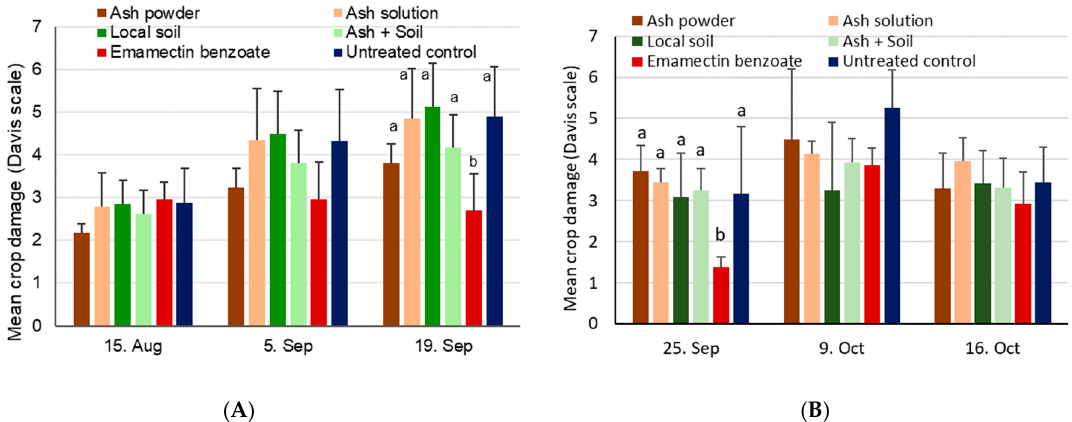
Figure 8. Mean crop damage induced by FAW + SD after application of ash- or soil-based treatments during vegetative growing stages conducted in the 2018 season. Within a given date, bars sharing the same letters are not significantly different from each other, while no letter indicates a lack of difference. ( A ) Site 1 near Wa, Upper West, Ghana, where treatments were applied on 16 August, 30 August, and 13 September. ( B ) Site 2 near Accra, Ghana, where treatments were applied on 20 September and 10 October.